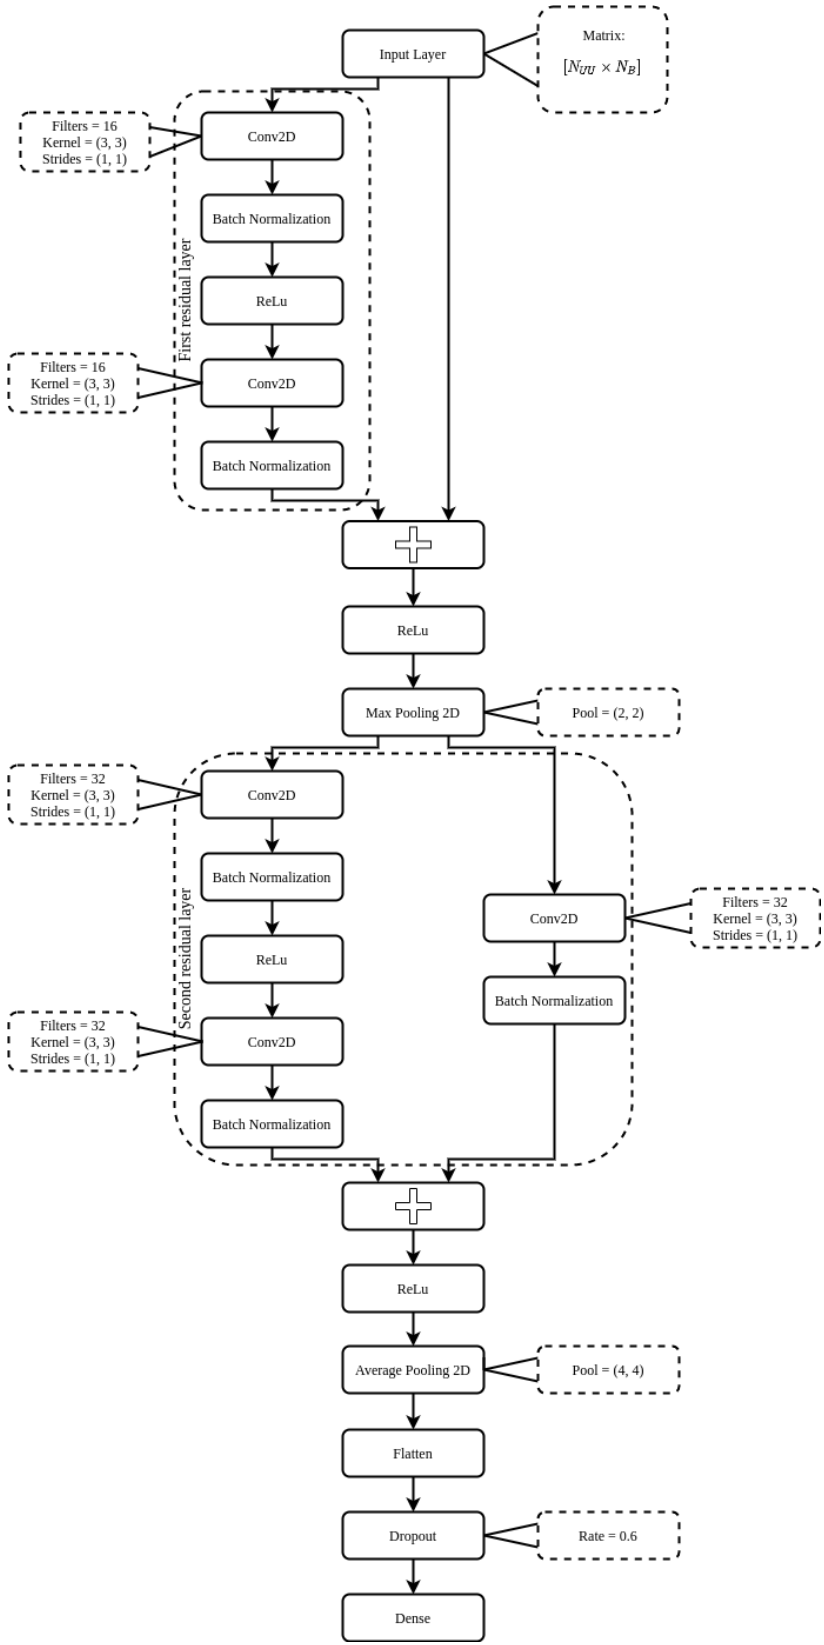
Figure 2. The proposed ResNet